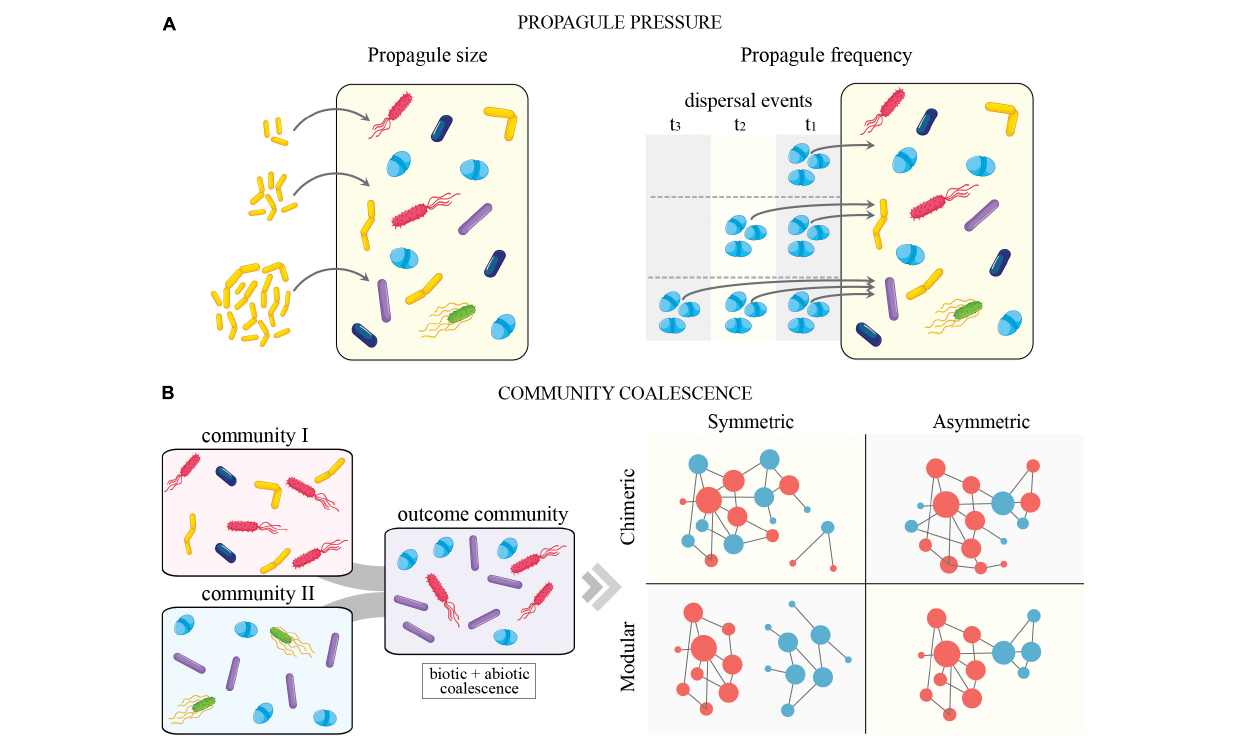
FIGURE 2 | (A) Conceptual depiction of propagule pressure (propagule size (left) and frequency (right) in microbial systems. (B) Conceptual diagram of community coalescence. Community coalescence is defined as the mixing of entire communities and their environments ( sensu Rillig et al., 2015, 2016). (B) (Left) illustrates community coalescence in microbial systems. (B) (Right) depicts a modified version of possible coalescence outcomes from Castledine et al. (2020). In brief, symmetric and asymmetric coalescence indicates the degree to which one input community dominates over another after coalescence. Modular and chimeric coalescence relates to the degree of pre-existing (in previous communities) and novel species interactions (after coalescence), respectively. See Castledine et al. (2020) for additional